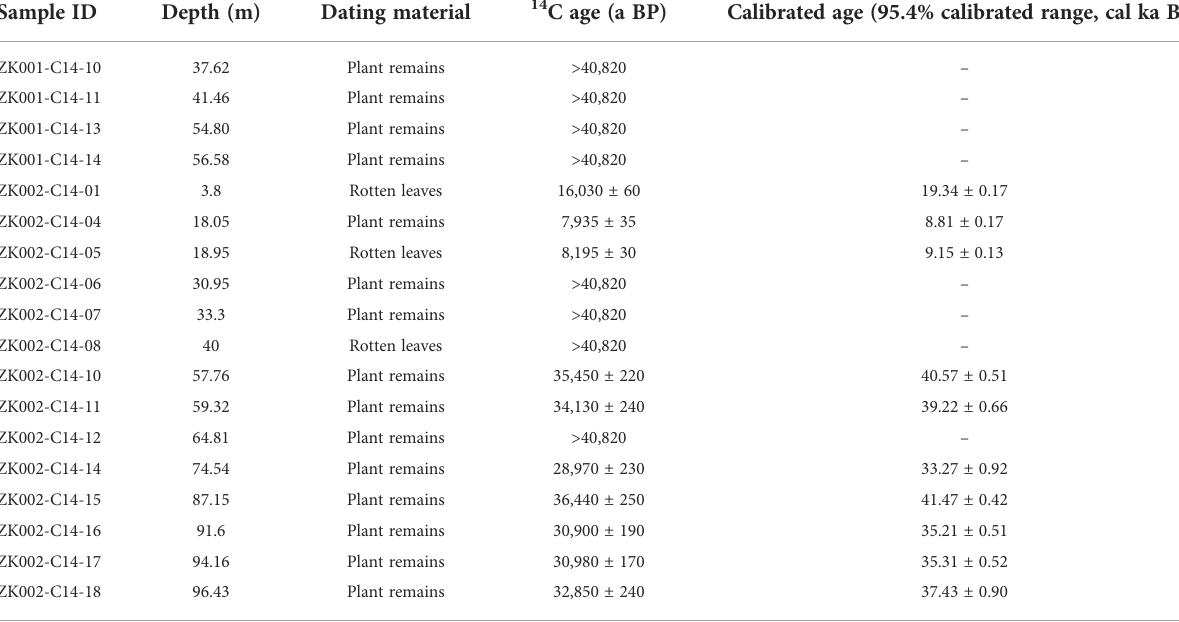
TABLE 1 14 C ages for samples from cores ZK001 and ZK002, the Chaoshan plain. Sample